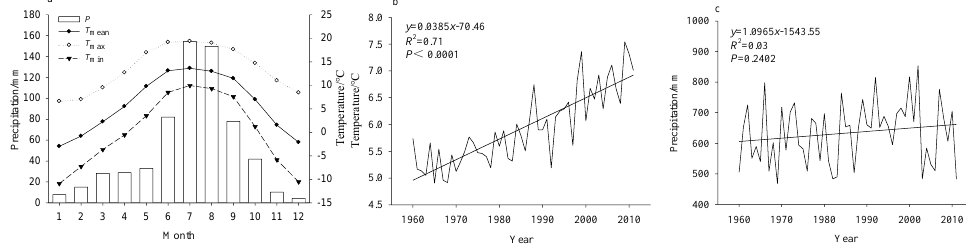
Figure 2. Climate data from the Shangri-La meteorological station (1960–2011). T max : monthly mean maximum temperature; T mean : monthly mean temperature; T min : monthly mean minimum temperature; P: monthly total precipitation. Table 1. Descriptions of the sampling sites.